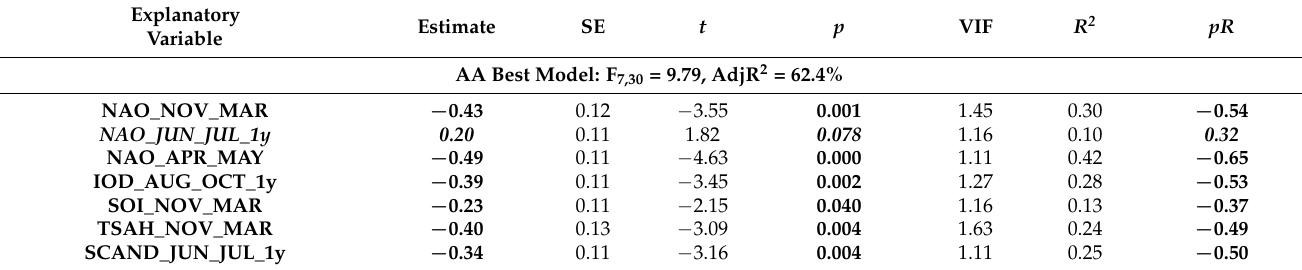
Table A17. Relationships between 15 climate variables and year and Annual Anomaly of the timing of spring migration for the Willow Warbler Phylloscopus trochilus caught at Bukowo, Poland, in 1982–2021. Symbols as in Tables 1 and A12 p < 0.05 marked in bold face, 0.05 < p < 0.1 in bold italics .